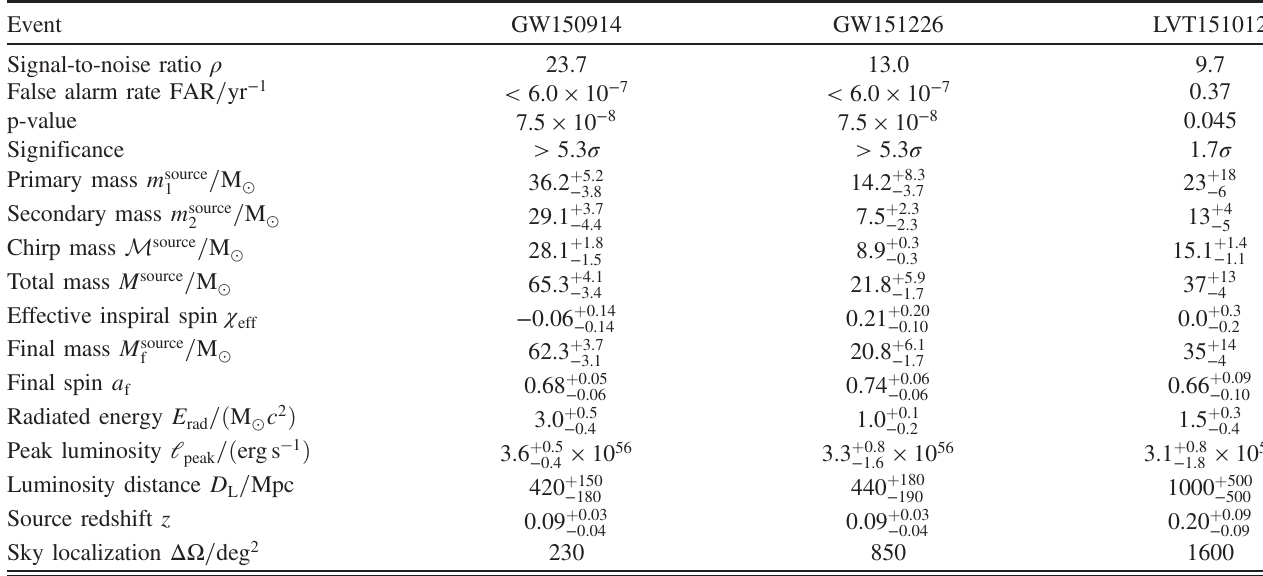
TABLE I. Details of the three most significant events. The false alarm rate, p-value, and significance are from the PyCBC analysis; the GstLAL results are consistent with this. For source parameters, we report median values with 90% credible intervals that include statistical errors, and systematic errors from averaging the results of different waveform models. The uncertainty for the peak luminosity includes an estimate of additional error from the fitting formula. The sky localization is the area of the 90% credible area. Masses are given in the source frame; to convert to the detector frame, multiply by ( 1 þ z ). The source redshift assumes standard cosmology